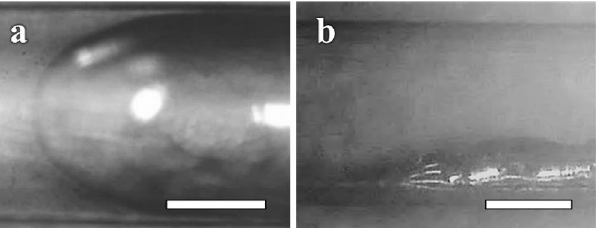
Figure 1. Microscope images of the Galinstan and water. ( a ) Microscope image in the cylidrical microchannel and ( b ) Microscope image in the square pole-shaped channel. The scale bars indicate 250